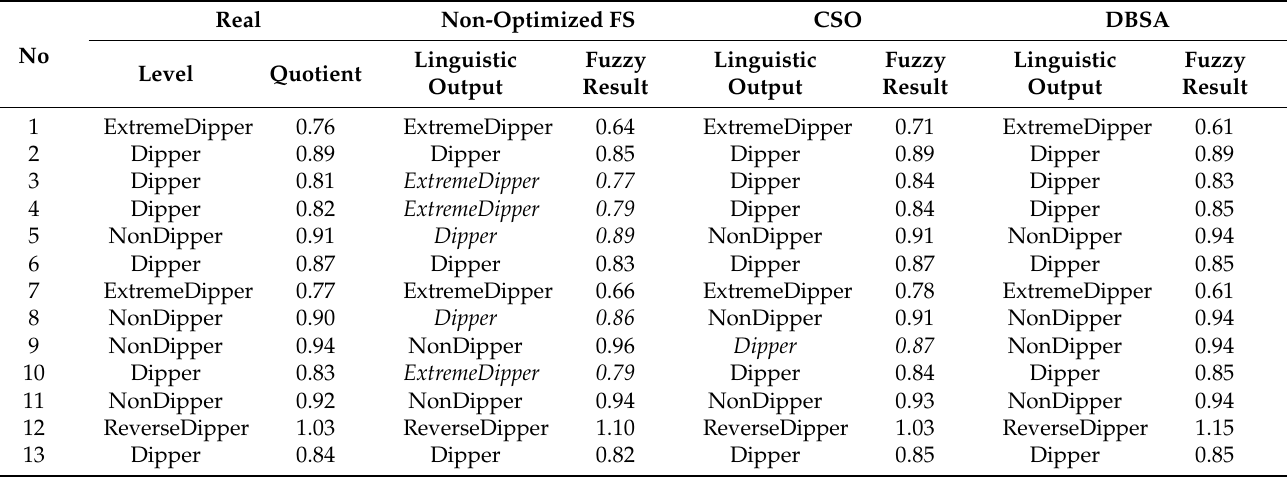
Table 9. Comparative of the results provided for the nocturnal blood pressure profile optimized using Gaussian membership